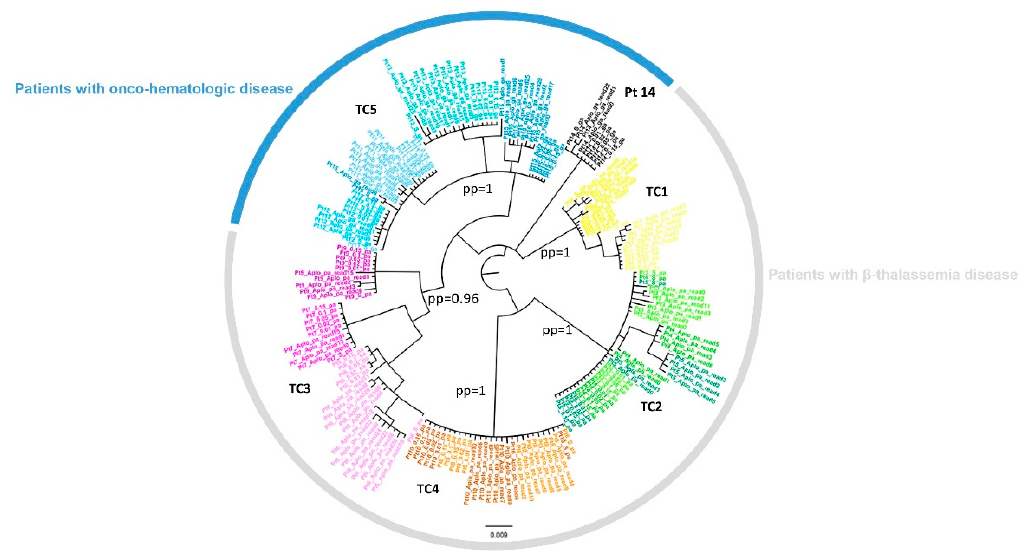
Figure 1. NS5A Bayesian Tree. The NS5A phylogenetic tree following the Bayesian method. The colors represent the different transmission clusters. Pt 14 was outside TC5. Transmission clusters (TC) were identified by a posterior probability ≥ 0.90.